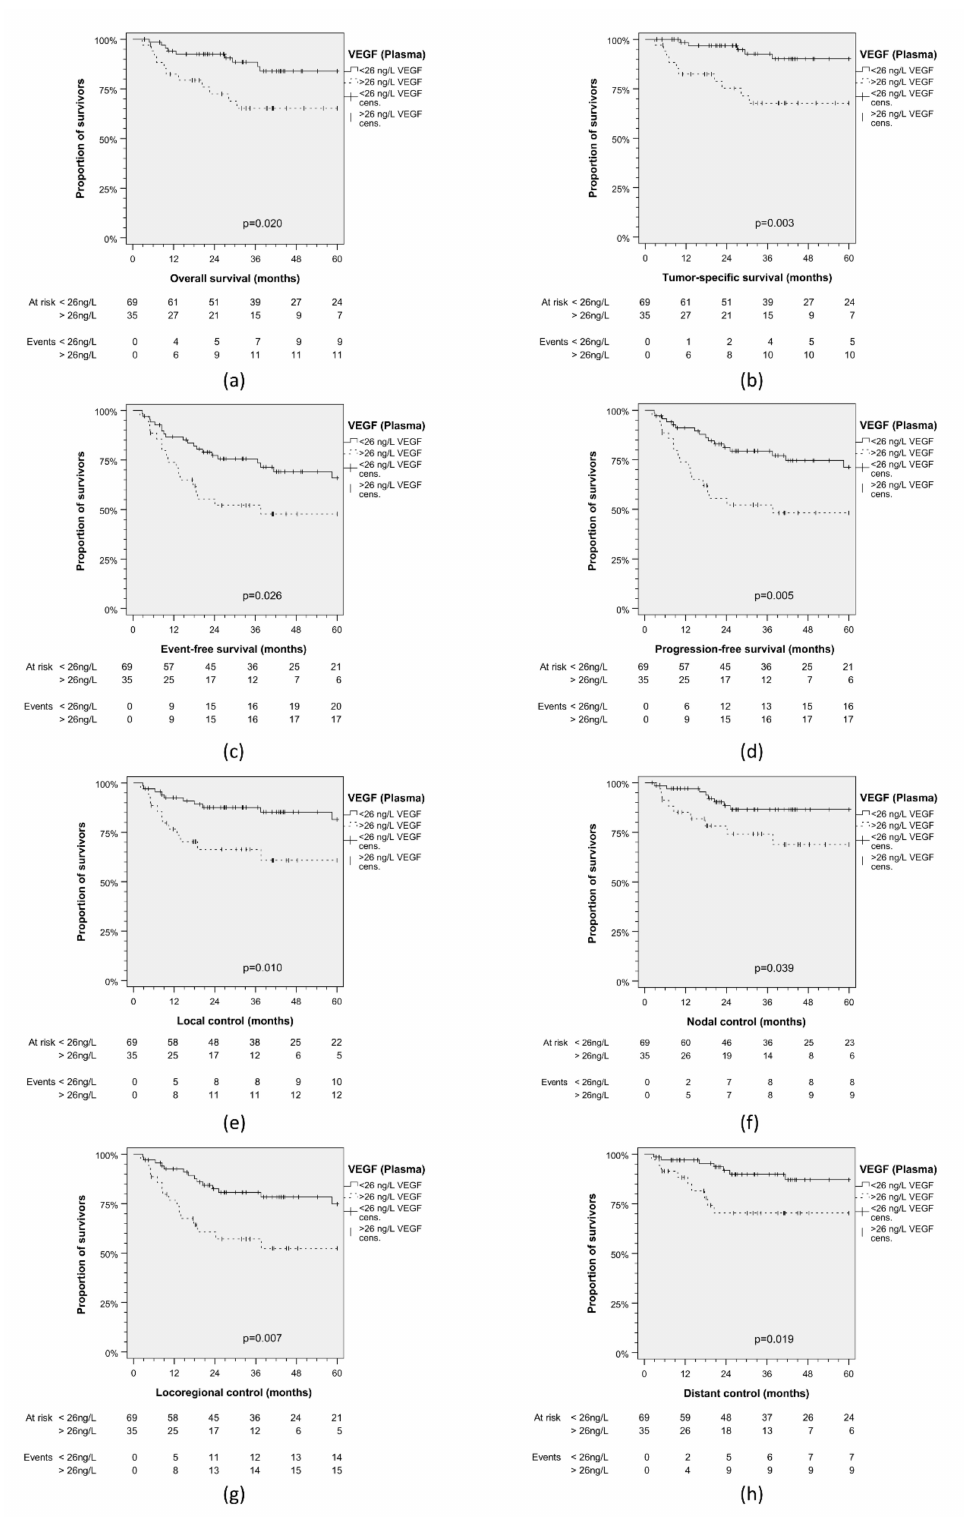
Figure 3. Kaplan–Meier plots for cumulative survival in HNSCC patients from the independent validation cohort stratified according to VEGF in pre-therapeutic plasma. ( a ) Overall survival; ( b ) tumor-specific survival; ( c ) event-free survival; ( d ) progression-free survival; ( e ) local control; ( f ) nodal control; ( g ) loco-regional control; ( h ) distant control. p values shown are from 2-sided log-rank